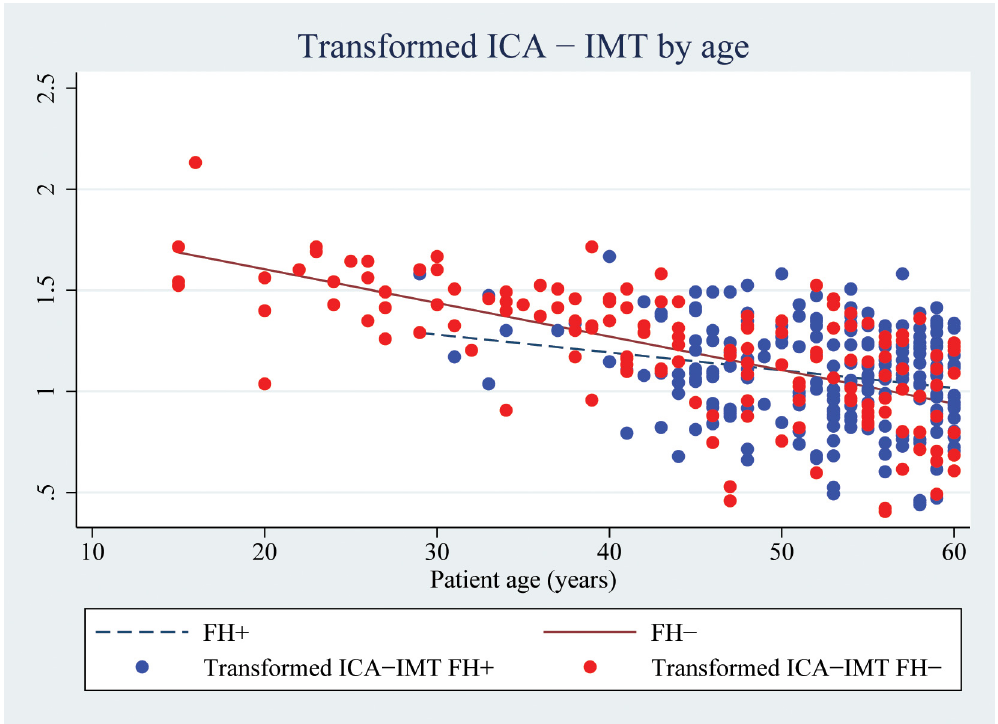
p Fig 1. Transformed ICA-IMT by age. The distribution of the transformed ICA-IMT (1/ ICA-IMT) is plotted by age in 382 young and middle-aged ischemic stroke patients included in the Norwegian Stroke in the Young Study (NOR-SYS) in Bergen, Norway 2010 – 2015. Lines of best fit for FH+ and FH- patients are superimposed on the plot. p There is a strong negative correlation between the 1/ ICA-IMT and age (Pearson ’ s r = -0.514; p < 0.001). The large divergence of the lines at young age indicates the predictive value of a positive FH on the transformed ICA-IMT is high at young age and the lines converging with progressing age shows the association attenuates with increasing